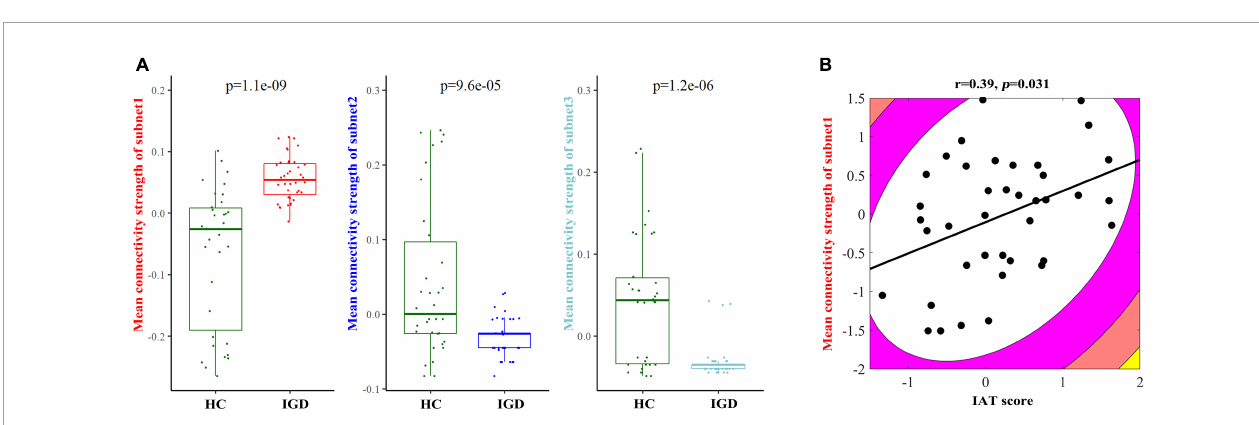
FIGURE4 (A) Between-group comparison results of the mean fractional anisotropy- (FA–) weighted structural connectivity strength in each subnetwork between young people with internet gaming disorder (IGD) and healthy controls (HC). (B) An illustration of the correlation result between the mean FA-weighted structural connectivity strength of subnet1 and the IAT score in the IGD